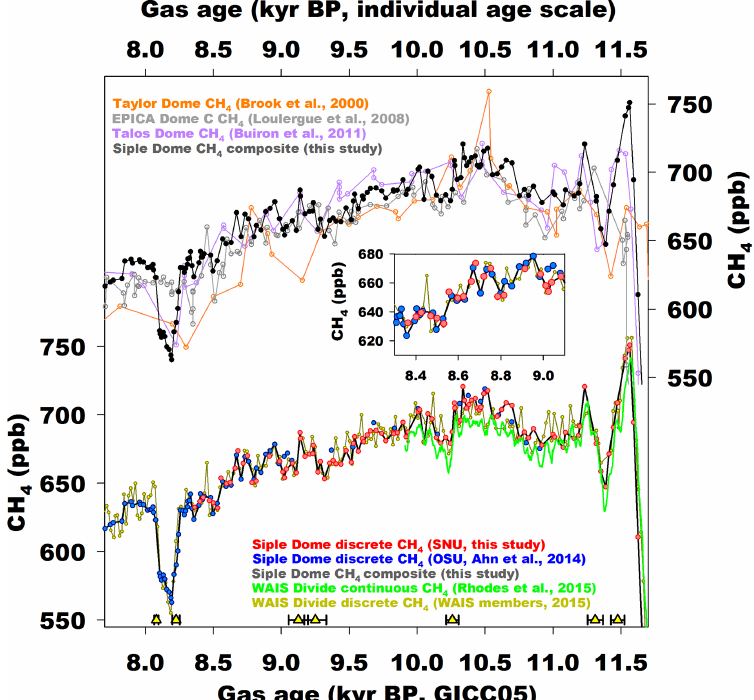
Figure 1. Atmospheric CH 4 concentration reconstructions during the early Holocene. Top: new high-resolution Siple Dome composite (black; this study and Ahn et al., 2014) compared with previous records from Taylor Dome (orange; Brook et al., 2000), EPICA Dome C (grey; Loulergue et al., 2008), and Talos Dome (purple; Buiron et al., 2011). Bottom: Siple Dome CH 4 records measured at OSU (blue; Ahn et al., 2014) and SNU (red; this study). Siple Dome composite (black line) is plotted with WAIS Divide discrete (dark yellow; WAIS Divide project members, 2015) and continuous measurement records (green; Rhodes et al., 2015). Inset: enlarged plot showing overlapped interval between OSU and SNU Siple Dome